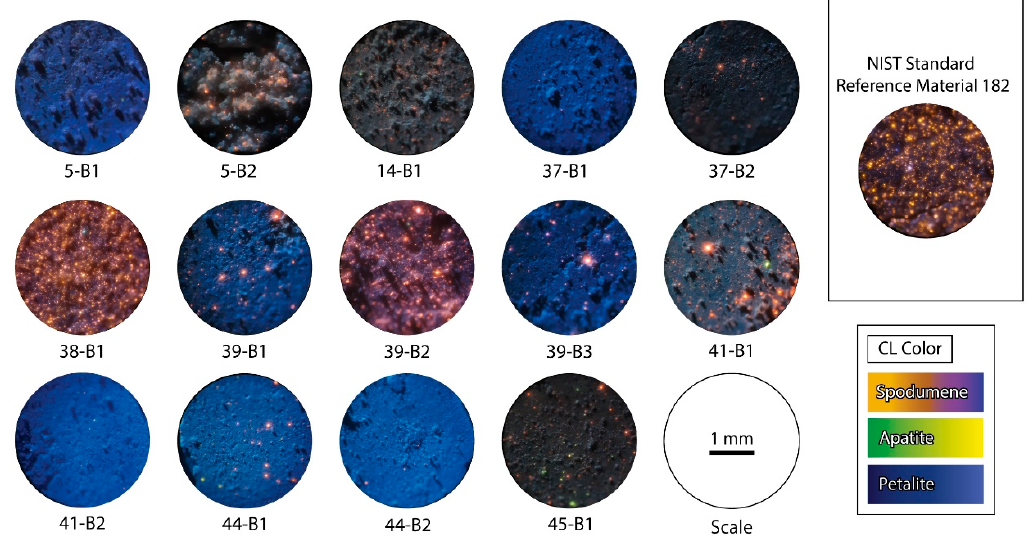
Figure 11. Microphotographs in cold cathodoluminescence (CL) of the petalite pellets made with the different samples of the aplite-pegmatites of the BA field. The CL color of petalite is blue, spodumene has CL colors between orange and purple, and apatite goes from green to yellow. Spodumene and apatite have a very strong luminescence and petalite has a weak luminescence. All pictures were taken with the same acceleration voltage (approximately 6 kV) [11,13,16,19,20].